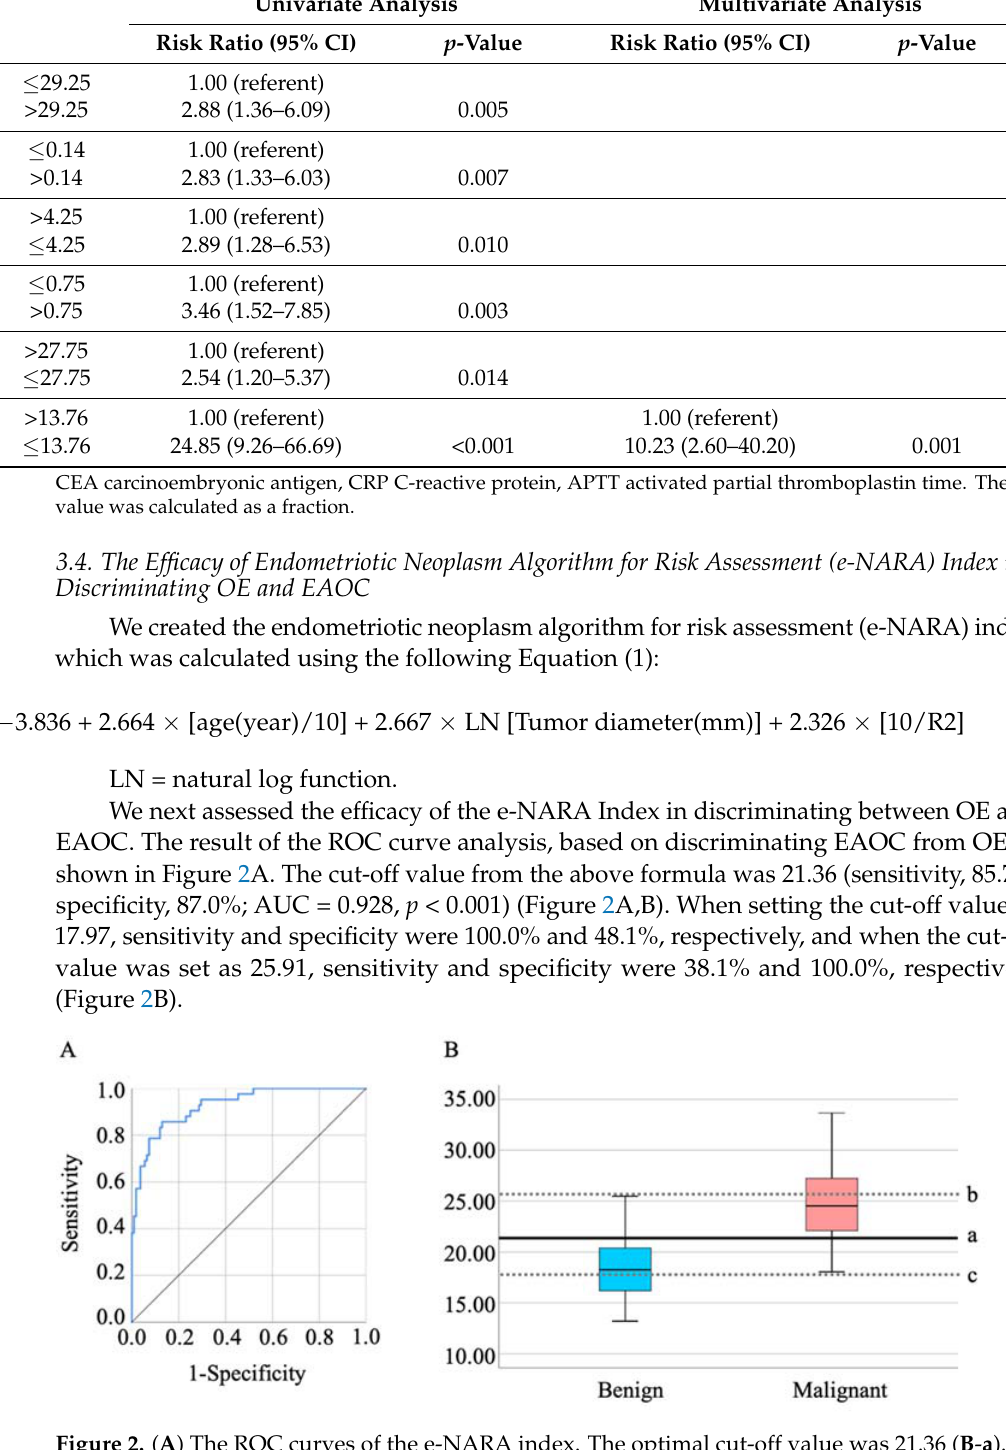
Figure 2. ( A ) The ROC curves of the e-NARA index. The optimal cut-off value was 21.36 ( B - a ). To make each specificity and sensitivity 100%, the cut-off values of the e-NARA index were 25.91 ( B - b ) and 17.97 ( B - c ), respectively.